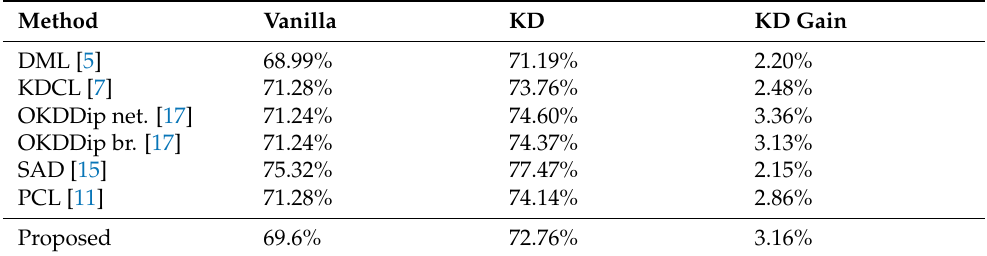
Table 6. Comparison with state-of-the-art works for ResNet-32 architecture trained on CIFAR- 100 dataset.